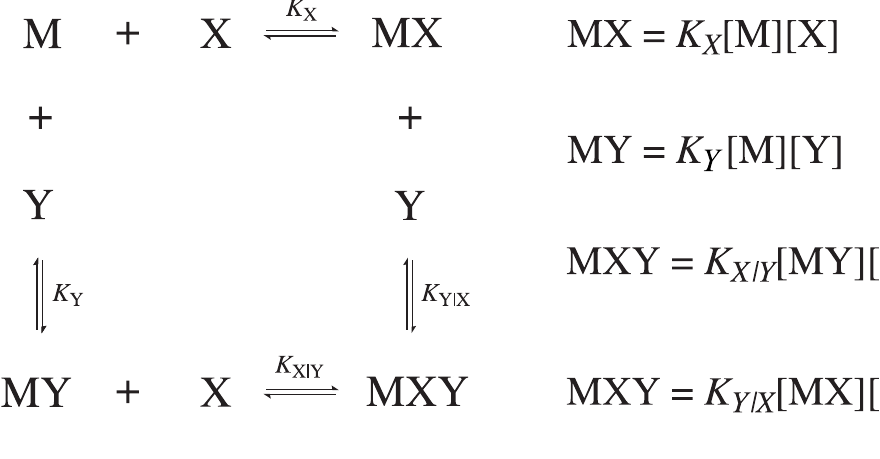
and K , X Y and K X j Y Y j X